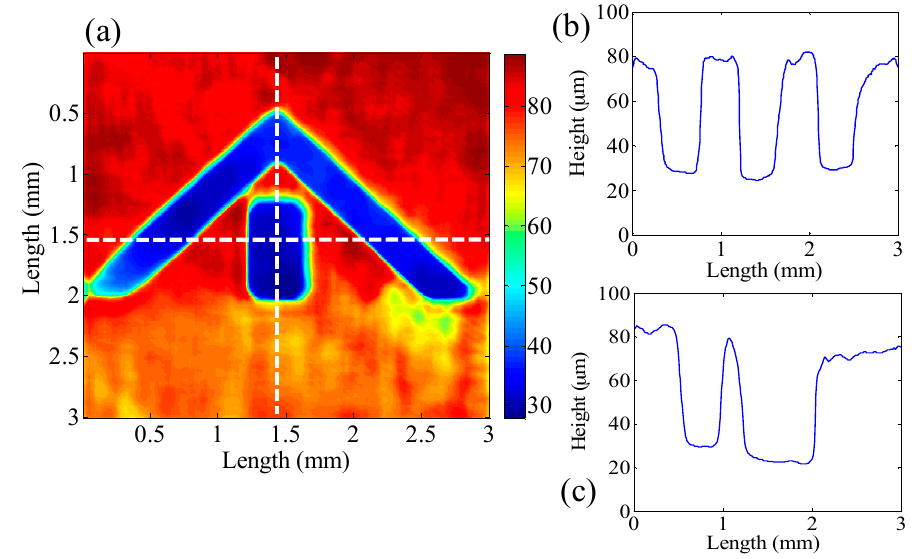
Figure 7. Tomographic image of the full-field OCT system; ( a ) Enface image of the VLSI 50 µm step height standard target; ( b , c ) Cross-sectional profiles along the horizontal and vertical white-colored dashed lines in ( a ), respectively.